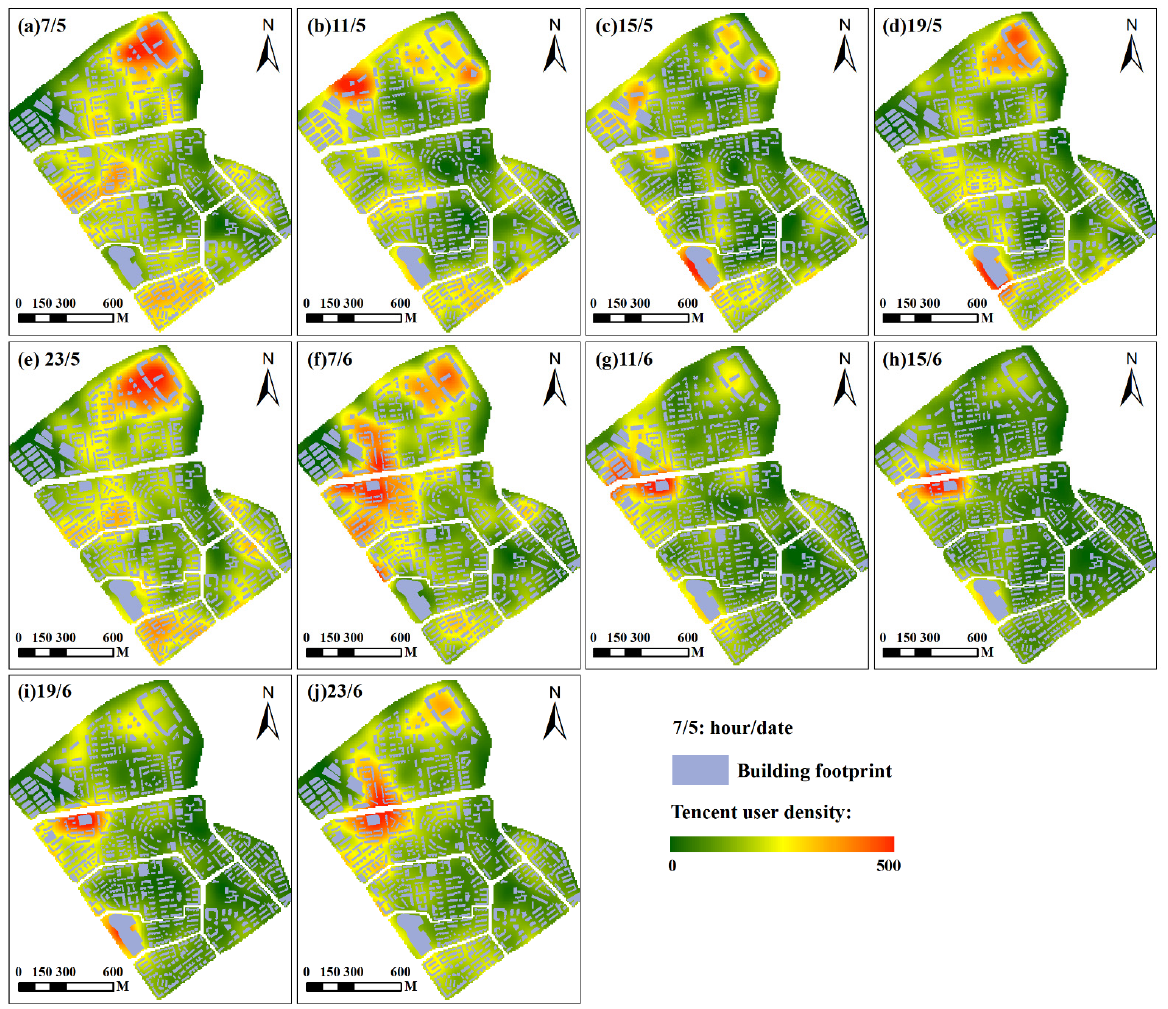
Figure 6. The mapping results of Tencent user density for different times in our study area. The redder the color, the higher the density of Tencent users. Hour/date: 7/5 represents 7 o’clock on 5 June. Type of day: 5 June was a working day, and 6 June was a non-working day. Figure 7 displays the temporal changes in the average Tencent user density in the study area over the two days. Clearly, obvious periodic oscillations occurred for the aver- age user density curve of business buildings over the two days. There is almost no one in commercial buildings late at night. The temporal changes in average user density of resi-